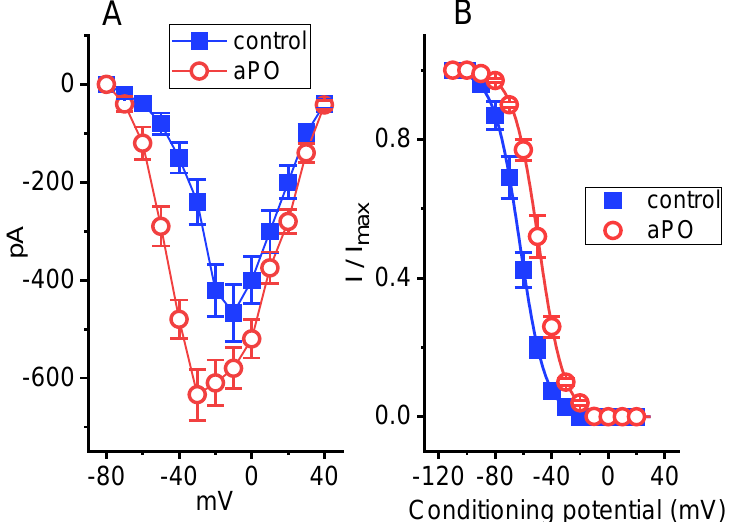
Figure 2. Stimulatory effect of aPO on averaged current–voltage (I-V) relationship ( A ) and steady- state inactivation curve ( B ) of I Na present in GH 3 cells. Cells were kept bathed in Ca 2+ -free Tyrode’s solution containing 10 mM TEA. ( A ) Averaged I-V relationships of I Na in the absence ( ■ ) and pres- ence ( ○ ) of 10 μM aPO (mean ± SEM; n = 8 for each point). The examined cell was held at −80 mV